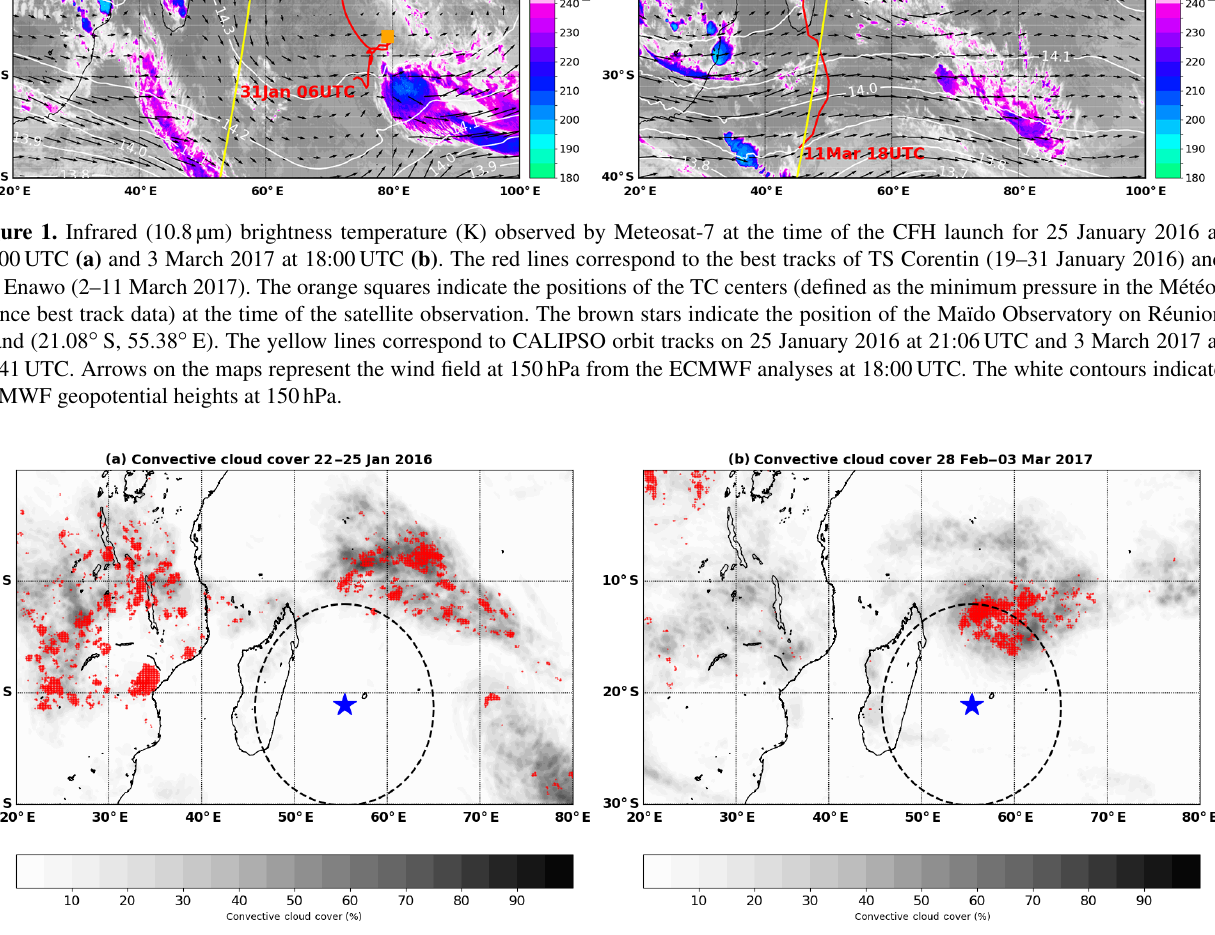
Figure 2. Maps of convective cloud cover (gray shading) computed using 3-hourly data of Meteosat-7 infrared brightness temperature at 5km resolution for 22–25 January 2016 (a) and 28 February–3 March 2017 (b) . The red dots indicate pixels with the coldest tops ( ≤ 190K) that capture the deepest part of convection. The dashed circle indicates a range ring of 1000km around the Maïdo Observatory (blue